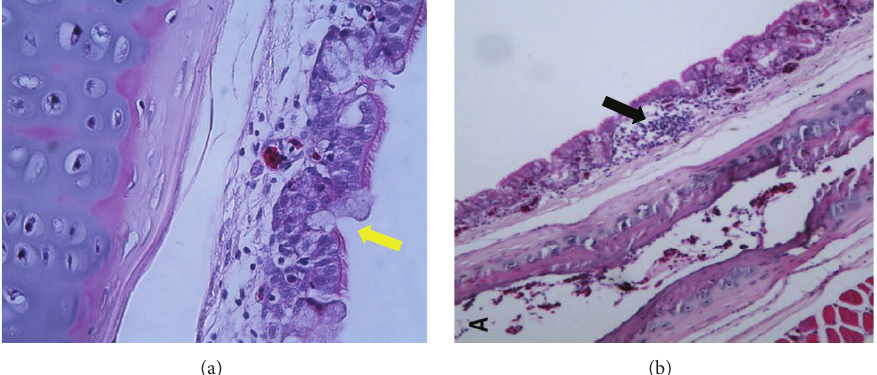
Figure 4: Histopathological changes in the trachea of naturally IBV infected chicken. Note: the marked infiltration of lymphocytes within the epithelia (black arrow (b)) and evidence of mucosal secretions of goblet cells (yellow arrow